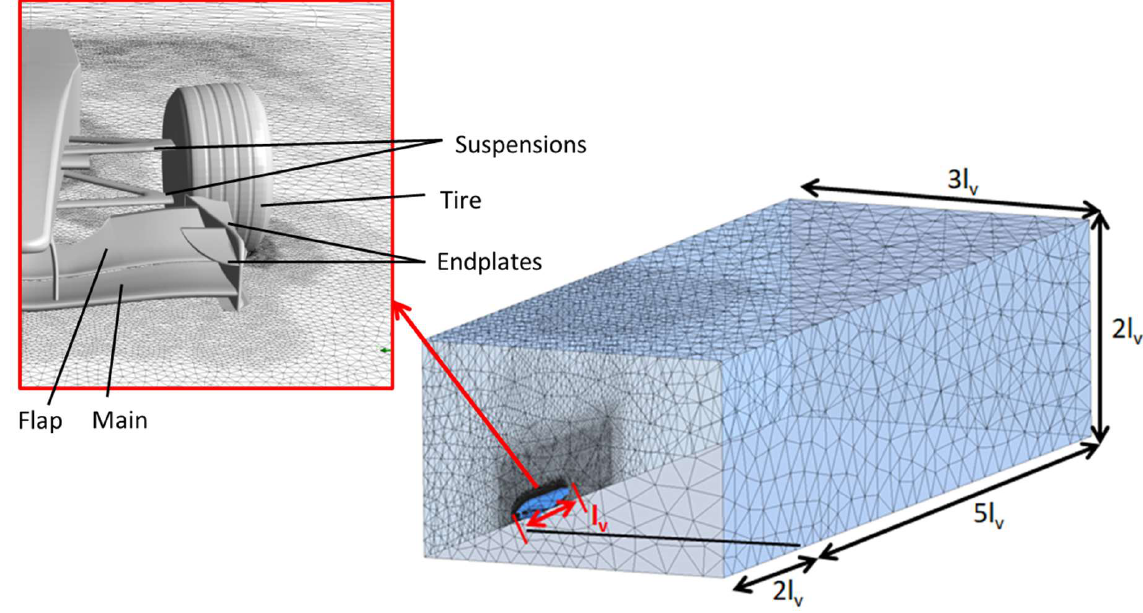
Figure 7. Computational domain and geometry details of the front wing and wheel.